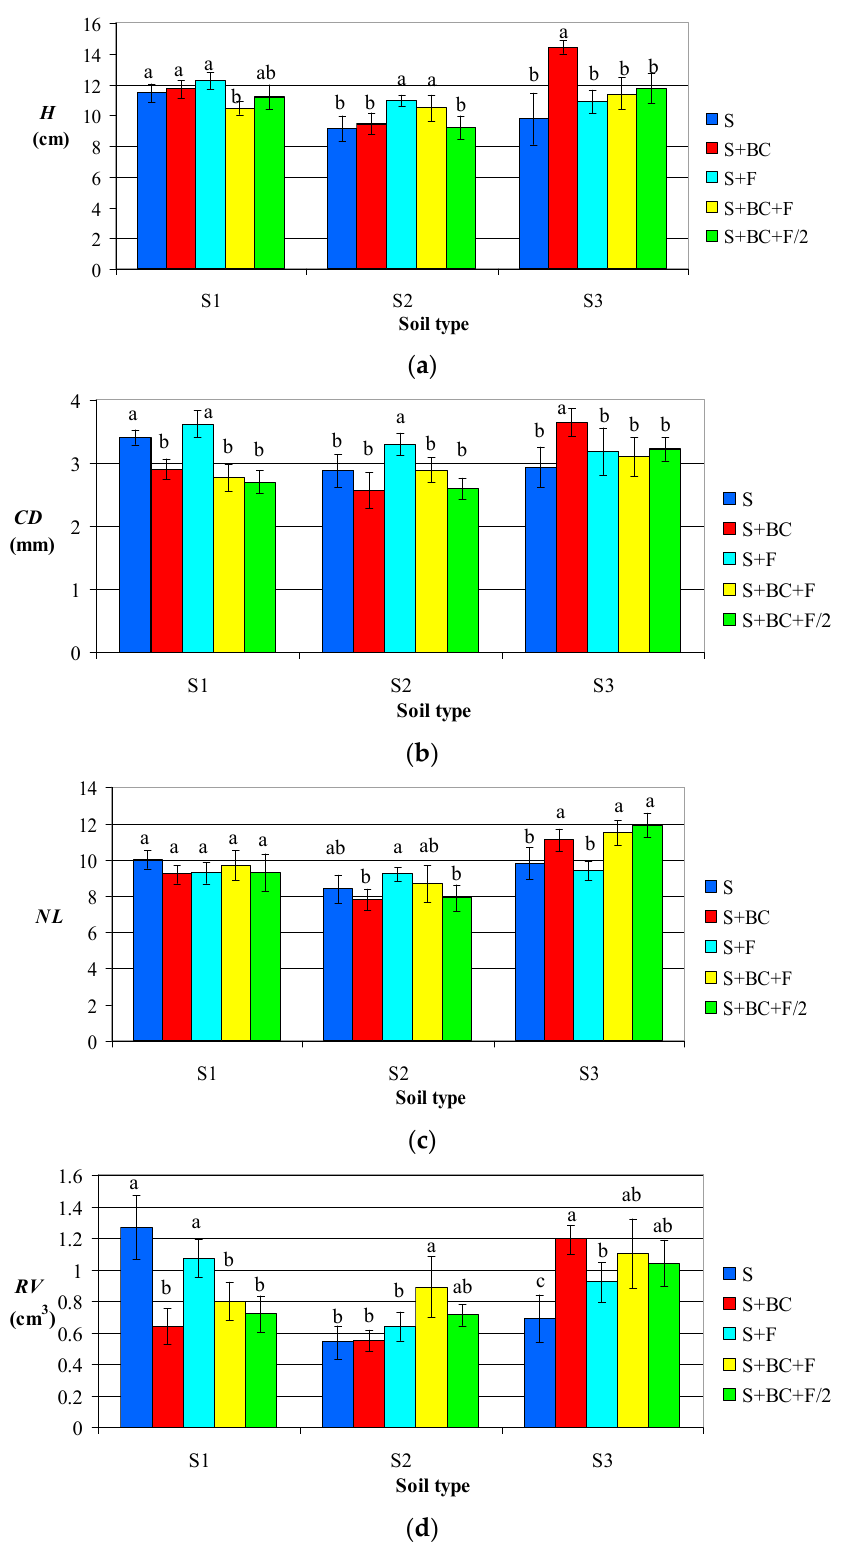
Figure 3. Mean values ± margins of error of plant height ( a ); collar diameter ( b ); number of leaves ( c ); and root volume ( d ) for different treatments, 109 days after sowing; (BC) biochar; (S1) fluvisol soil; (S2) chernozem soil; (S3) luvisol soil; (F) and (F/2) foliar fertilizer (0.2 mL/100 mL water and 0.1 mL/100 mL water); different letters corresponding to each soil type indicate a significant difference ( p < 0.05).